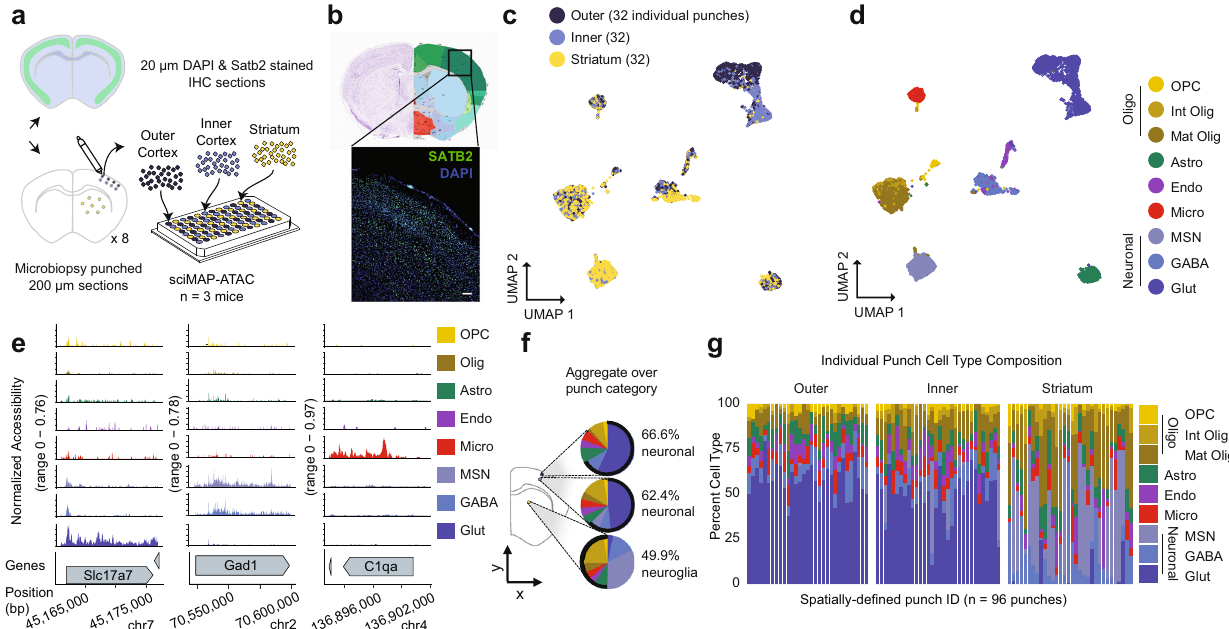
Fig. 2 sciMAP-ATAC reveals spatially distinct cell type composition in the mouse somatosensory cortex. a Experiment schematic of sciMAP-ATAC in the mouse somatosensory cortex. b DAPI and SATB2 staining of SSp cortex from sciMAP-ATAC histological section (scale bar, 50 µ m) in reference to matched rerference atlas image (Allen Mouse Brain Atlas: http://atlas.brain-map.org/atlas?atlas = 1&plate = 100960312, ref. 25 ). c UMAP of 7779 cells colored by punch location category. Each category contains cells from 32 spatially distinct tissue punches. d UMAP as in c , colored by cell type (OPC oligodendrocyte precursor cells, Int Olig intermediate oligodendrocytes, Mat Olig mature oligodendrocytes, Astro astrocytes, Endo endothelia, Micro microglia, MSN medium spiny neurons, GABA GABAergic (inhibitory) neurons, Glut glutamatergic (excitatory) neurons). e ATAC-seq pro fi les for cells aggregated by cell type for marker genes; colored by cell type as in d . f Aggregate cell type composition over punches belonging to the broad region categories; colored by cell type as in d . g Cell type composition for each of the 96 individual punches split by broad region category; colored by cell type as in d . Source data are provided as a Source data fi